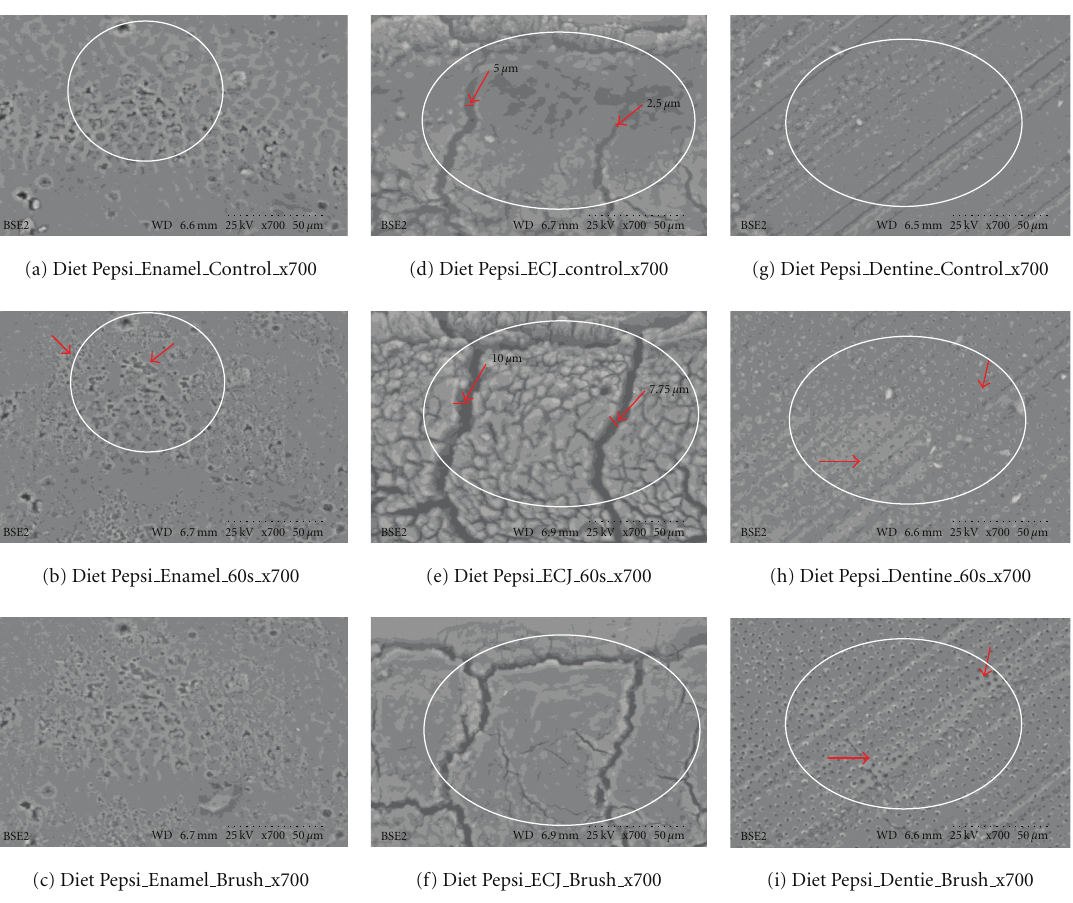
Figure 10: Diet Pepsi ( × 700). Outlined areas clearly show erosion with surface crenellations and profusion of shrinkage cracks from calcium loss when comparing (a), (d), and (g) to (b), (e), and (h). Minimal abrasion are present on the enamel, but red arrows from brush abrasion is clearly visible in (f); the surface cracks while enlarged from erosion appear narrower and less numerous, as the soft superficial material is lost to the action of the brush. Red arrows show that dentine tubules exposed from erosion appear clearer, wider, and more open as the soft surface material is lost to brush abrasion. These SEM results are also consistent with the calcium dissolution from swishes in Figure